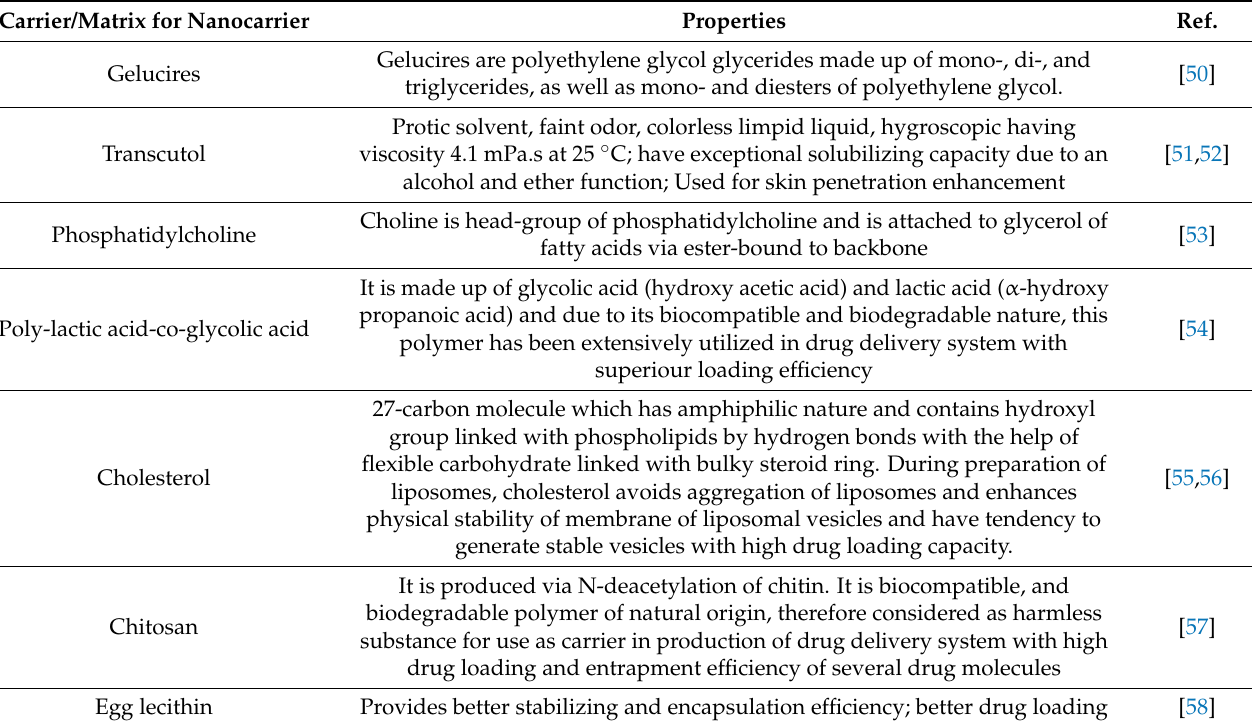
Table 4. Characteristics of carriers/matrices utilized in the production of colloidal drug delivery systems. Carrier/Matrix for